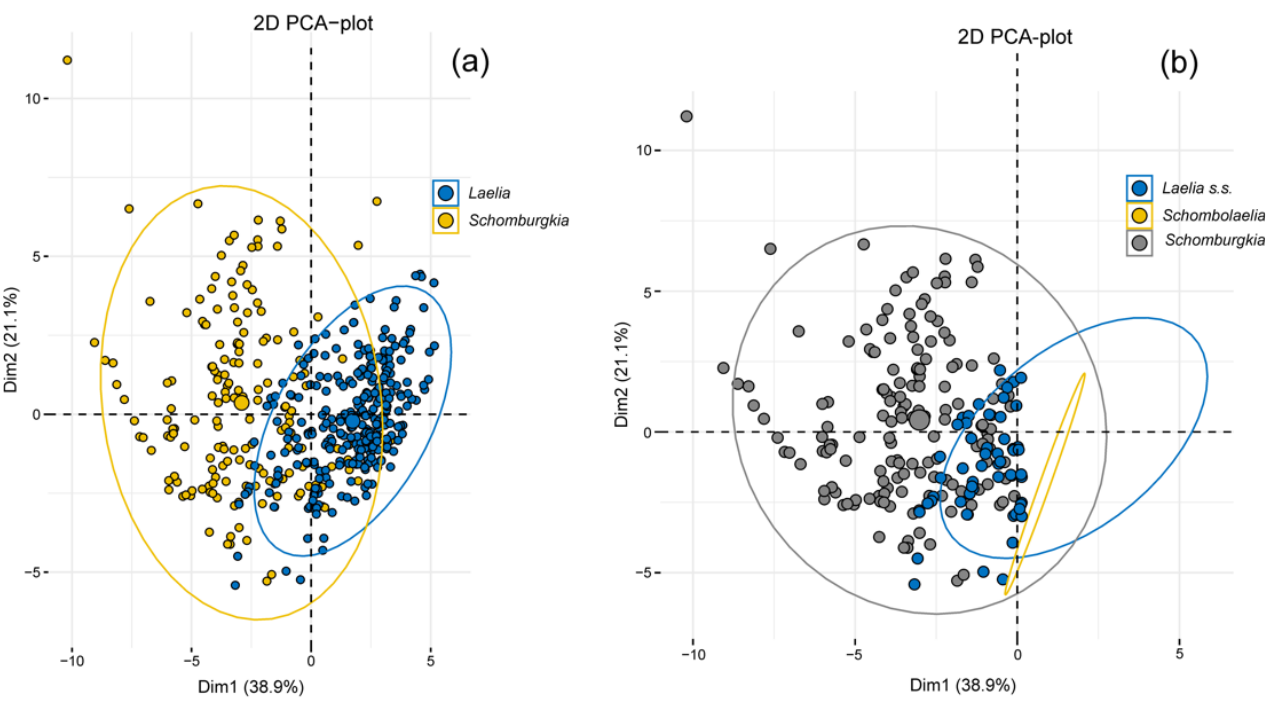
Figure 7. The principal component analysis (PCA) of the bioclimatic and topographical variables of the species of ( a ) Laelia s.s. and Schomburgkia and of ( b ) Laelia s.s., Schomburgkia, and × Schombolaelia .